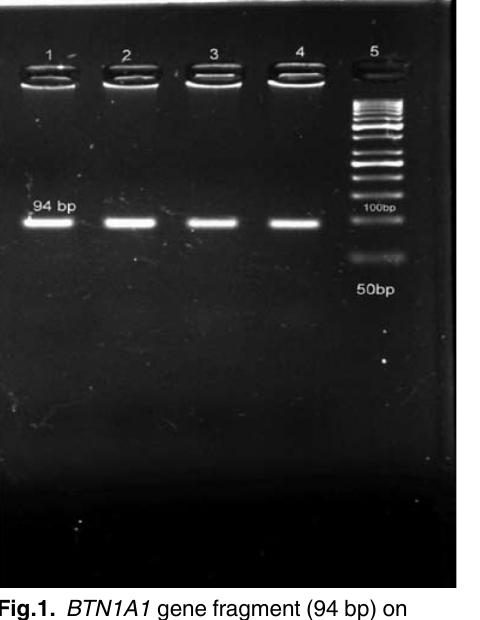
Fig.1. BTN1A1 gene fragment (94 bp) on 2.5 % agarose gel Lane 1-4: 94 bp product enclosing exon 3